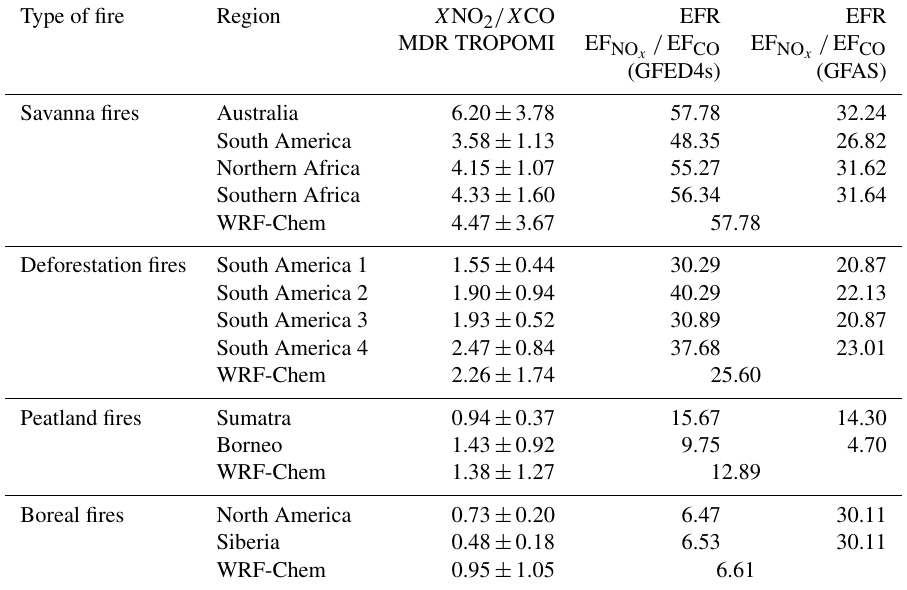
Table 2. For each region the average mole density ratio (MDR) derived from TROPOMI and WRF-Chem data and the ratio between EF NO and EF CO (EFR) for the GFED4s and GFAS emission databases. The MDR 1 σ standard deviation depicts day-to-day variability.